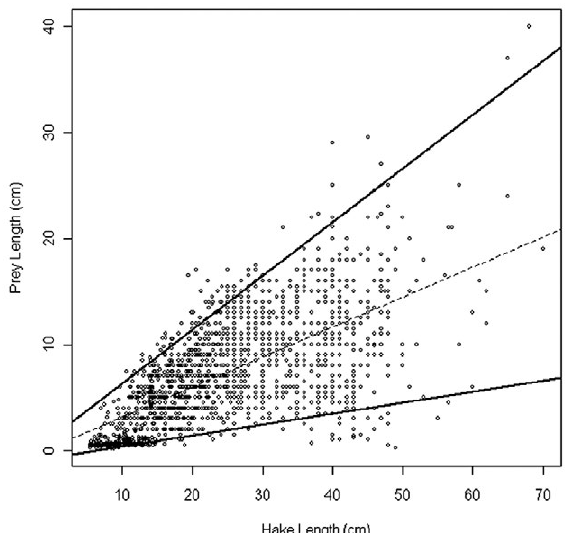
Fig. 5. – Hake size–prey size scatter diagram. Ontogenetic changes in prey sizes consumed with increasing hake size for all prey com- bined. Continuous lines, minimum (5 th quantile) and maximum (95 th quantile) prey sizes estimated by quantile regression; dashed line, mean prey sizes estimated by least-square regression; n=1702.